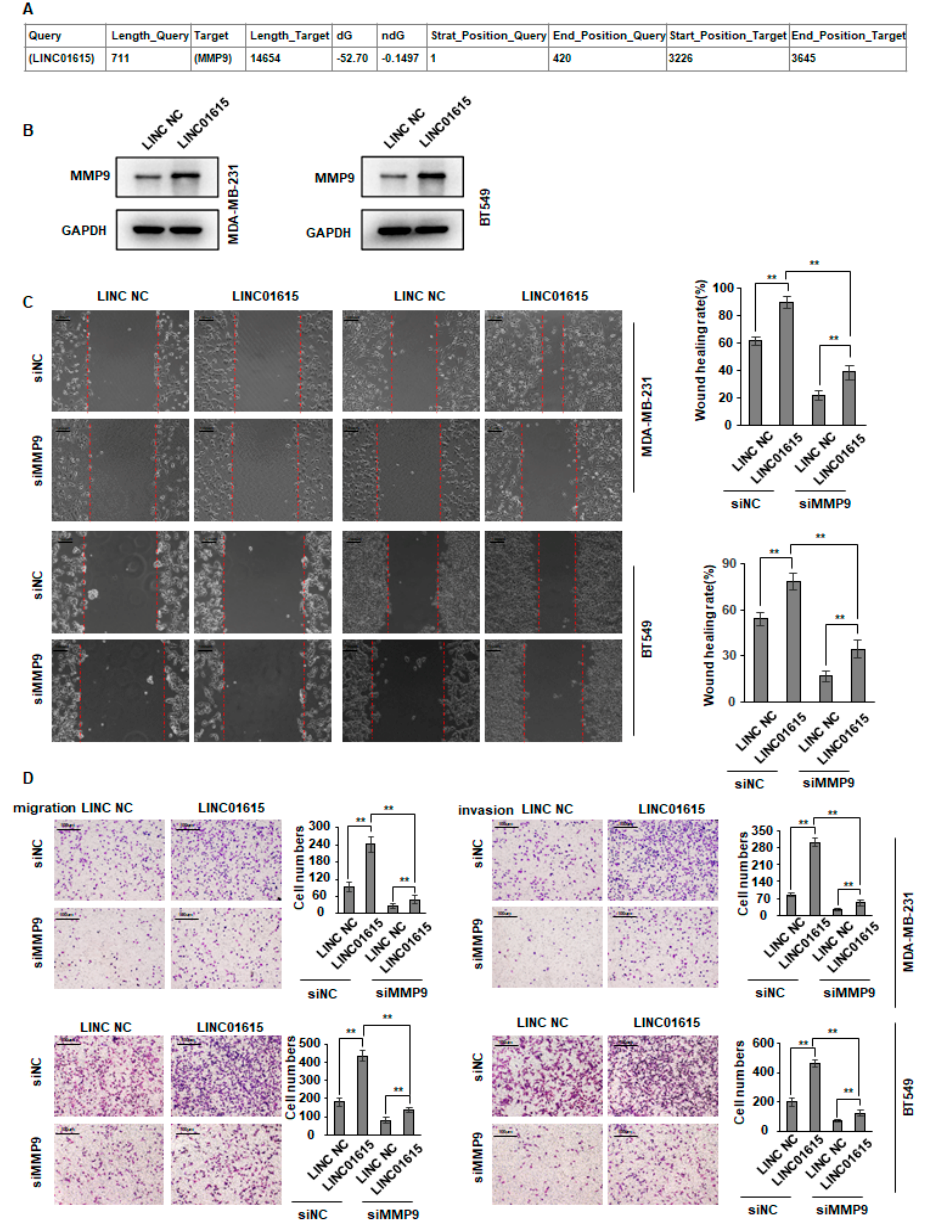
Figure 5. LINC01615 promotes the expression of MMP9. ( A ) Prediction of LINC01615 binding site to MMP9. ( B )The expression of MMP9 was detected by western blot (the original western blot can be found in Figure S5). ( C , D ) BT549 and MDA-MB-231 cells were transduced with LINC01615 or siMMP9 as indicated. Cell metastasis was determined by Scratch wound assays ( C ) or Transwell migration and Matrigel invasion assays ( D ). ** p <